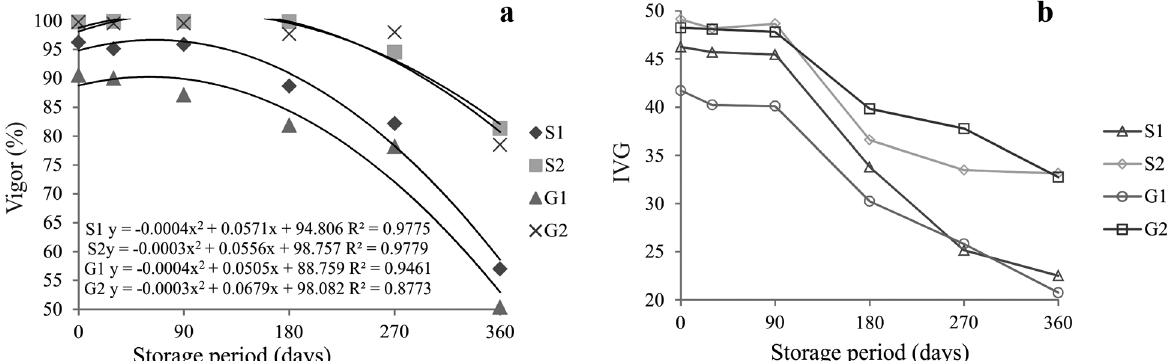
Figure 3 - Signi fi cant regression model to vigor by accelerated aging test of 24 hours (a) , and germination velocity index (b) of beans seeds and grains, of BRS Splendor variety, during storage periods. S1 and G1 seeds and grains from fi eld 1, S2 and G2 seeds and grains from fi eld 2, respectively Cascavel, PR-2013